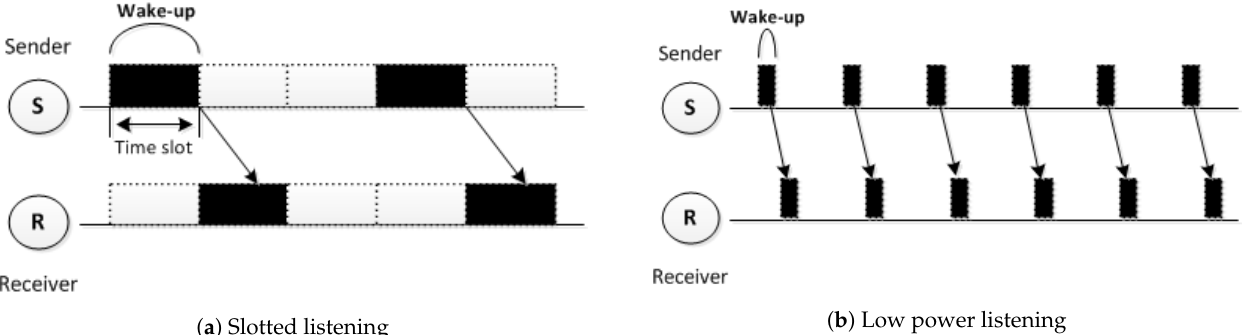
Figure 6. Duty-cycled operation in sensor